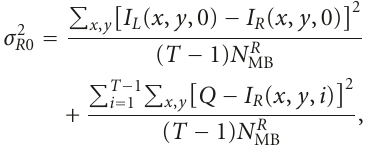
pixel in position ( x , y ) of i th frame of layer 2. Layer 2 consists of predicted frames of right view. In our stereoscopic codec, we used temporal error concealment for layer 2, where the frames are referred to previous layer 2 and current layer 1 frames as described in Section